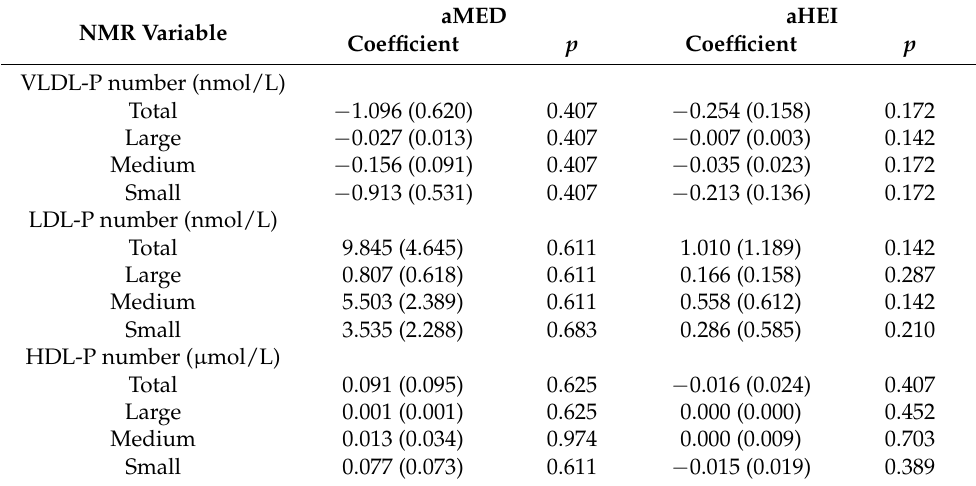
Table 3. Adjusted associations between each advanced lipoprotein profile and the alternate Mediter- ranean Diet (aMED) and alternate healthy eating index (aHEI) scores. Coefficients were estimated by multiple linear regression models. aMED aHEI